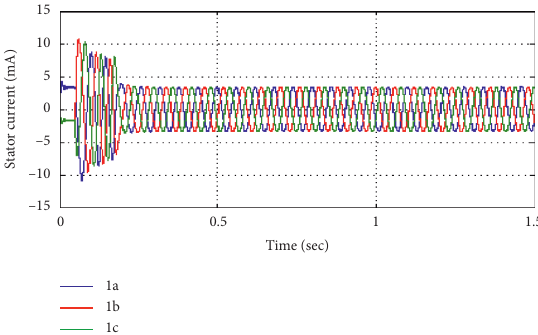
Figure 7: Three-phase stator current at